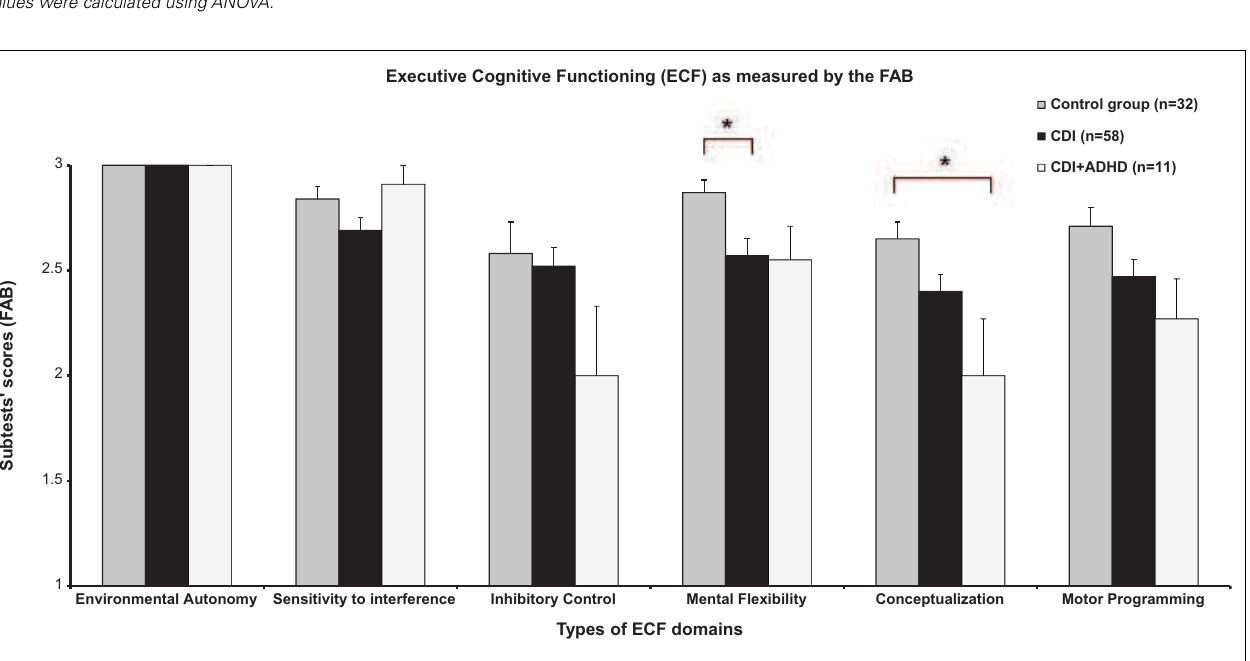
values were calculated using ANOVA.